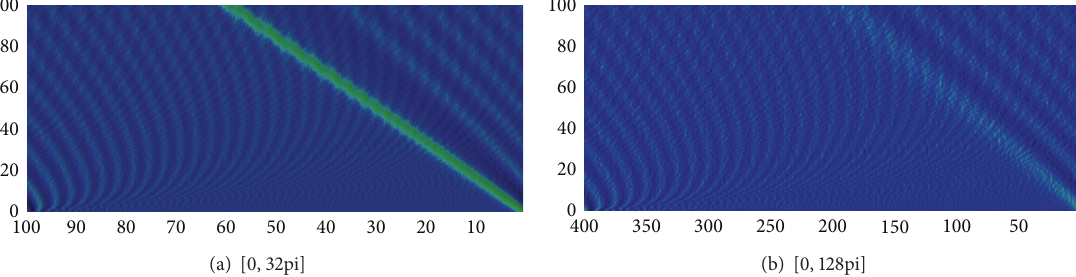
Figure 2: Time evolution for the hydrodynamics equation together with initial wave 𝑢 = 2 sech 2 (𝑥) . Time runs from 0 at the bottom of the figure to 100 at the top.